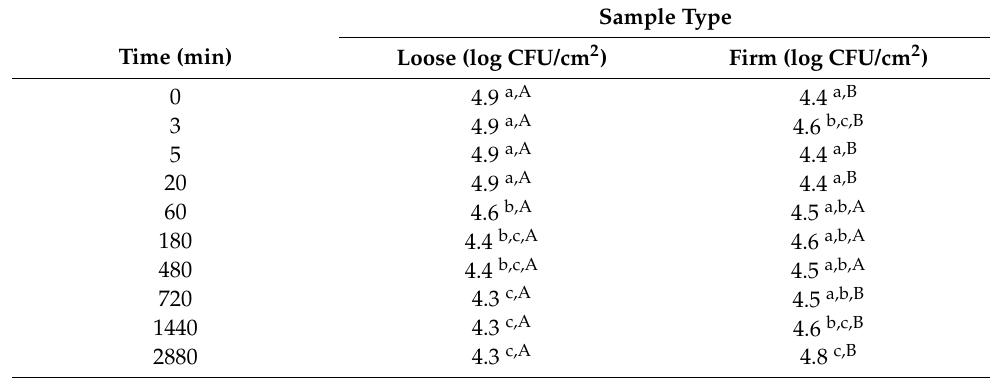
Table 1. Populations of Shiga toxin-producing Escherichia coli (STEC) cells grown in tryptic soy broth (TSB) represent loose and firm attachment to beef brisket tissues during 48 h (2880 min) of storage at 4 ◦ C. Time × sample type was significant ( p < 0.0001). As the time × sample type × tissue type interaction was not significant ( p > 0.05), data for adipose and lean tissue attachment are combined for each data